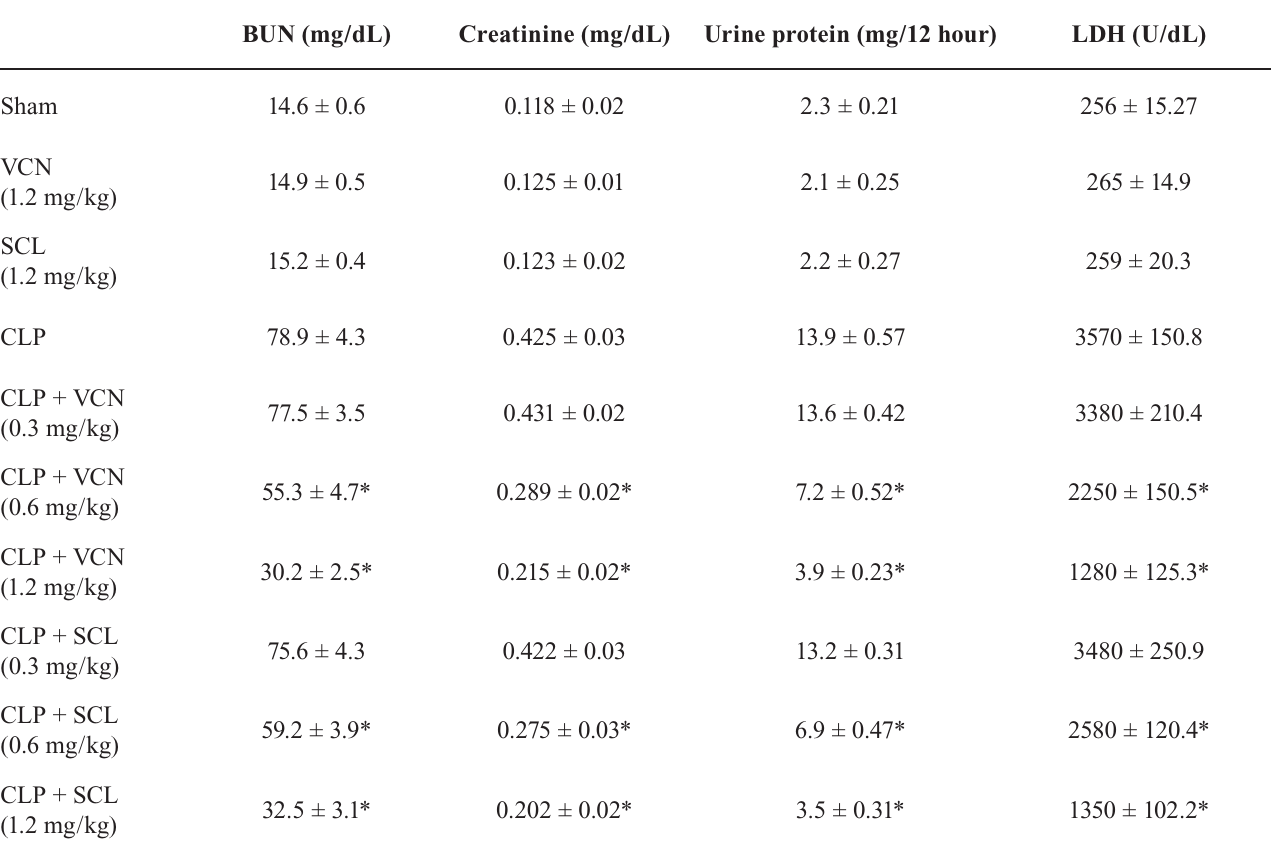
TABLE I - Effects of VCN or SCL treatment on plasma levels of BUN and creatinine and urine level of protein in CLP-operated